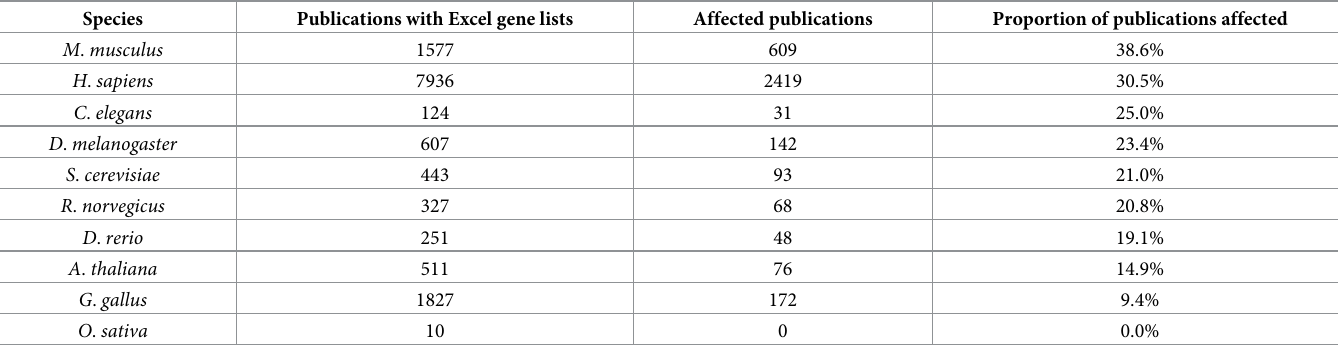
Table 4. Gene name errors stratified by organism under